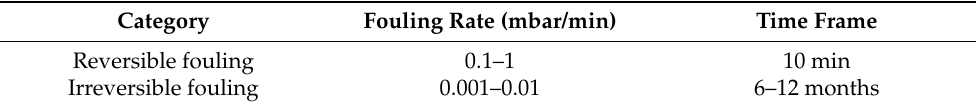
Table 3. The typical range of different fouling rates occurring at full scale